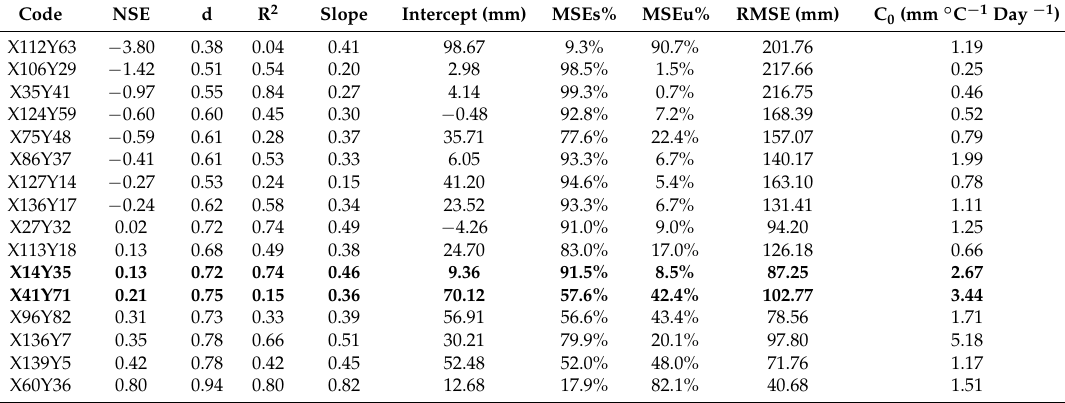
Table 3. SWE model performance indicators at the 16 measurement stations. Scatter plots for